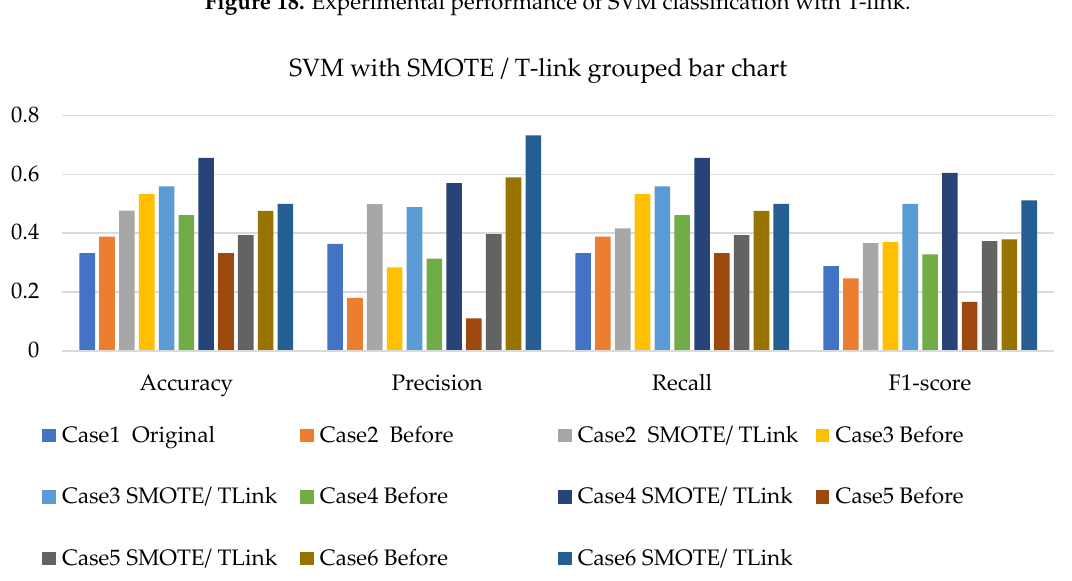
Figure 18. Experimental performance of SVM classification with T-link.